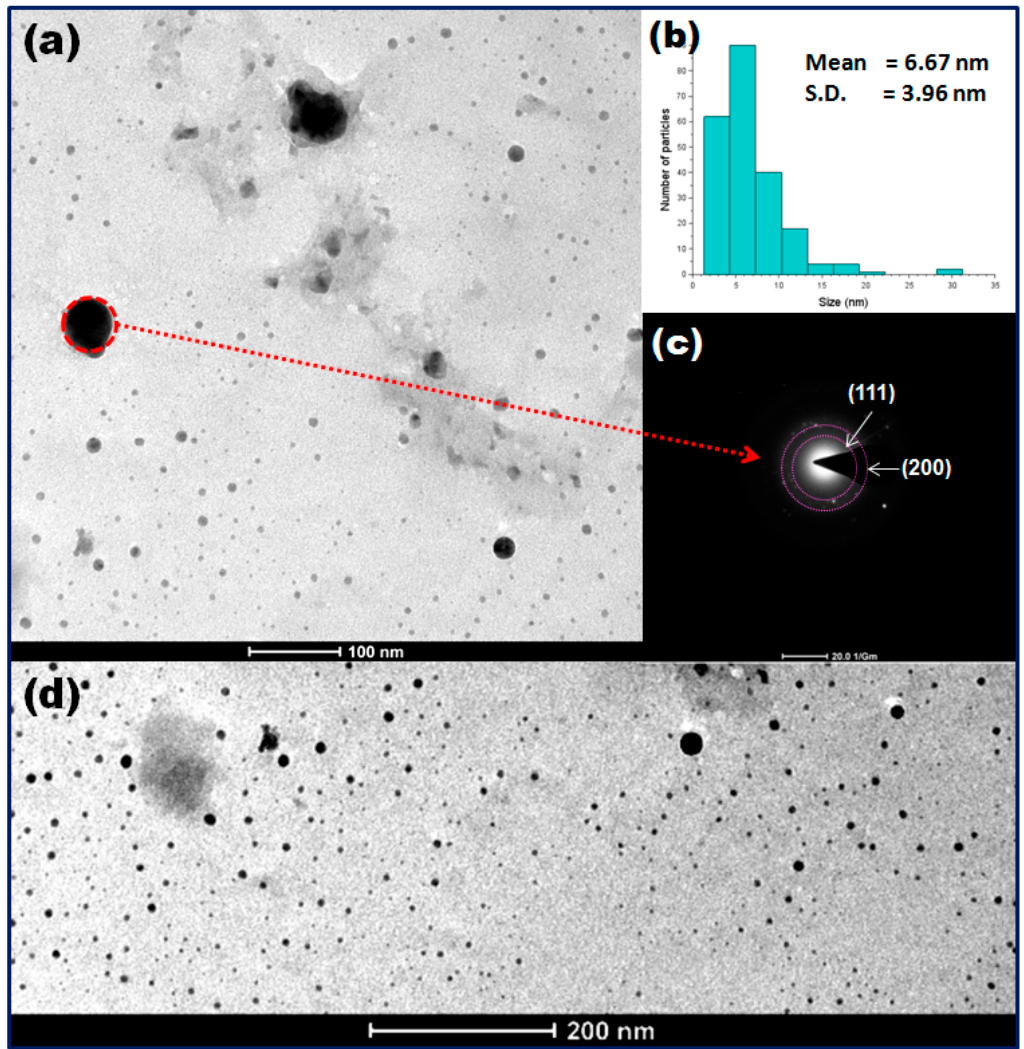
Figure 3. ( a , d ) TEM (transmission electron microscope) images of Cu 2 O nanoparticles synthesized in solution, ( b ) size distribution pattern and ( c ) SAED pattern.